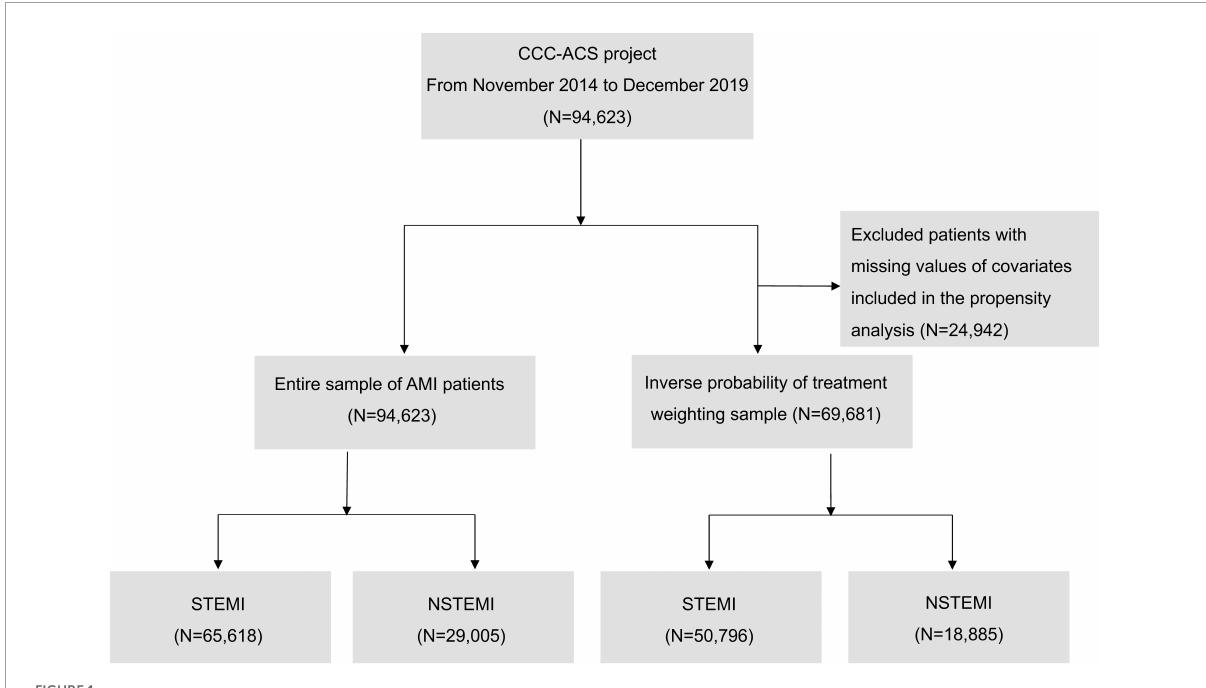
FIGURE1 The flowchart of participant inclusion and exclusion. AMI, acute myocardial infarction; NSTEMI, non-ST-segment elevation myocardial infarction; and STEMI, ST-segment elevation myocardial